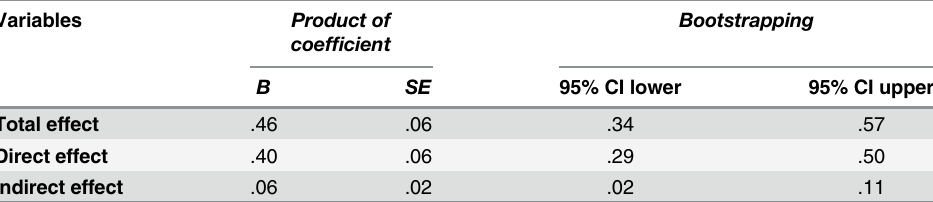
Table 3. The mediating effects of depression on the relationship between natural elements and job satisfaction.